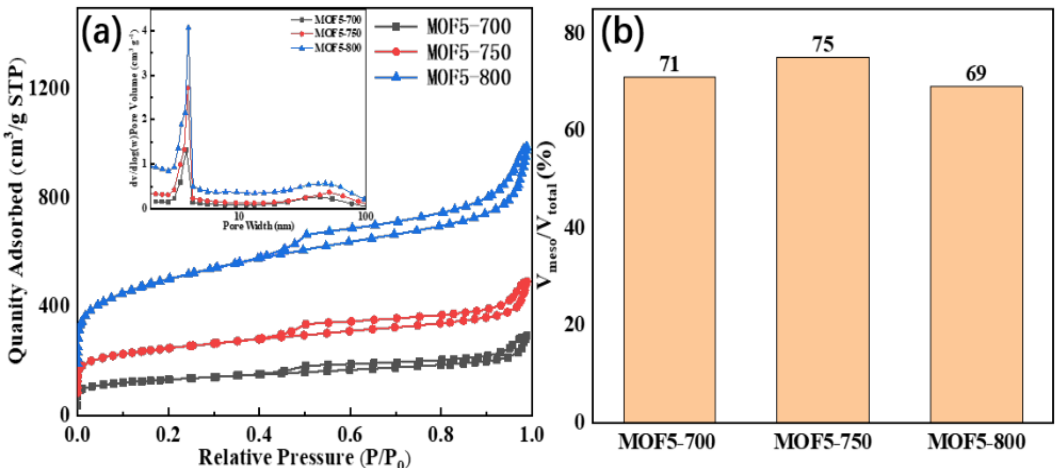
10 of 17 Compared with the CH 3 COOH conversion rate, the calcination temperature signifi- cantly affects the reactivity. Therefore, we investigated how the calcination temperature affects the catalytic reaction using relevant characterization. 2.2. Analysis of the Effect of Different Pyrolysis Conditions on MOFs-Derived Zinc-Based The specific surface area, pore volume, and pore size data of each sample are shown in Table 3 (where the raw data of sample MOF-5 was referenced to previous work [10]), and the N 2 adsorption/desorption isothermal curves and pore size distribution of the sam- ples are shown in Figure 12a. The catalysts obtained after high-temperature calcination have a multilayer structure of microporous (<2 nm), mesoporous (2 – 50 nm), and macro- porous (<50 nm) at the same time. According to IUPAC classification, it can be classified as H4 type hysteresis loop. H4 type hysteresis loop is usually found in some micro-meso- porous carbon materials and mesoporous zeolite molecular sieves, which is typical of AC type with narrow cleavage pore samples and also indicates three catalysts with narrow cleavage pore characteristics. Combined with the pore volume pore size distribution curves, it can be observed that the pore sizes of MOF5-700, MOF5-750, and MOF5-800 are concentrated at 3 – 4 nm, and their adsorbed nitrogen volumes gradually increase, which is consistent with the trend of pore volume data size (0.33, 0.87, and 1.06 cm 3 g − 1 ). We ana- lyzed the data on the ratio of mesopore pore volume to total pore volume and found (Fig- ure 12b) that MOF5-750 has the highest mesopore content, indicating that the higher mes- opore content facilitates the catalyst reaction. Table 3. Specific surface area pore volume and pore size data of each sample.